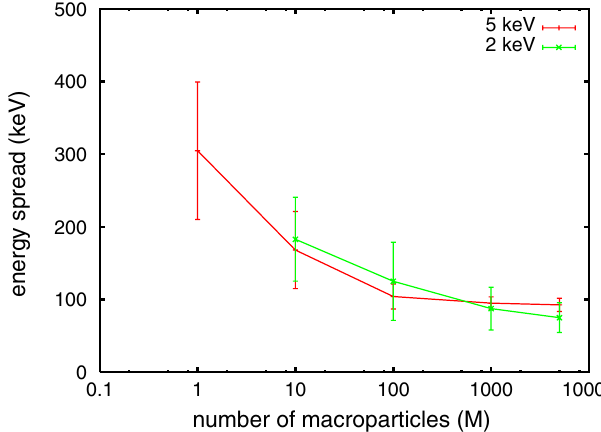
FIG. 5. (Color) Slice (or uncorrelated) energy spread at the exit of the linac as a function of the number of macroparticles used in the simulations. The reported slice energy spread is averaged over all the slices in the beam core. Two examples with 5 and 2 keV initial uncorrelated energy spread are